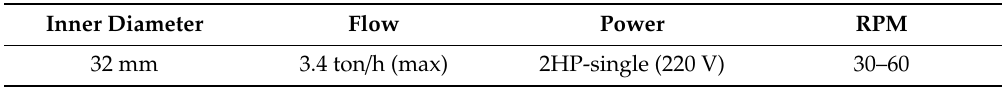
Table 1. Peristaltic pump